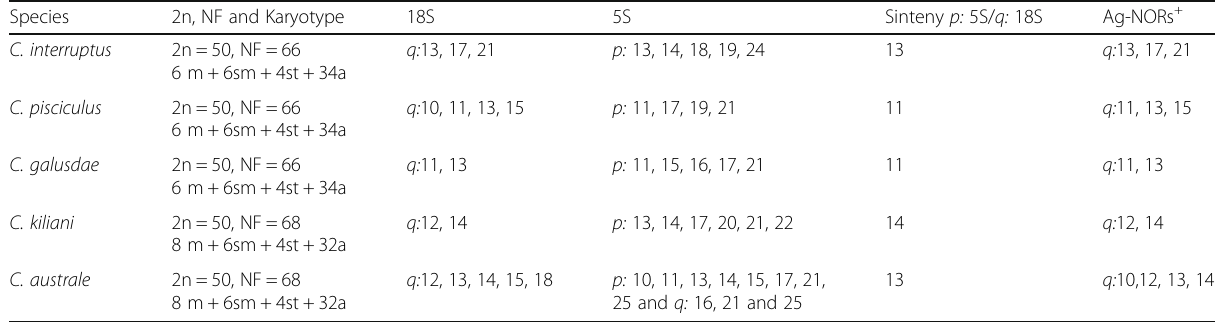
2n=chromosome number, NF=number or chromosome arms, q =long arm, p =short arm, m=metacentric, sm=submetacentric, st=subtelocentric,